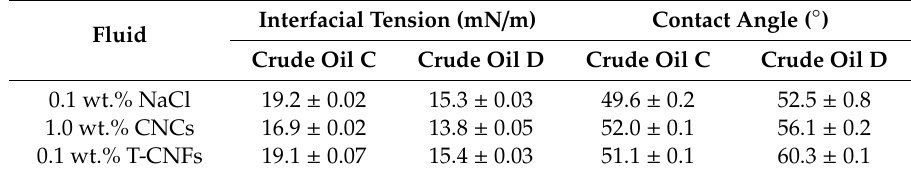
Table 7. Interfacial tension (IFT) and contact angle values. Each experiment lasted for 12 h. The average value from the last hour of the experiment is reported in the table. Measurements were made at ambient conditions.